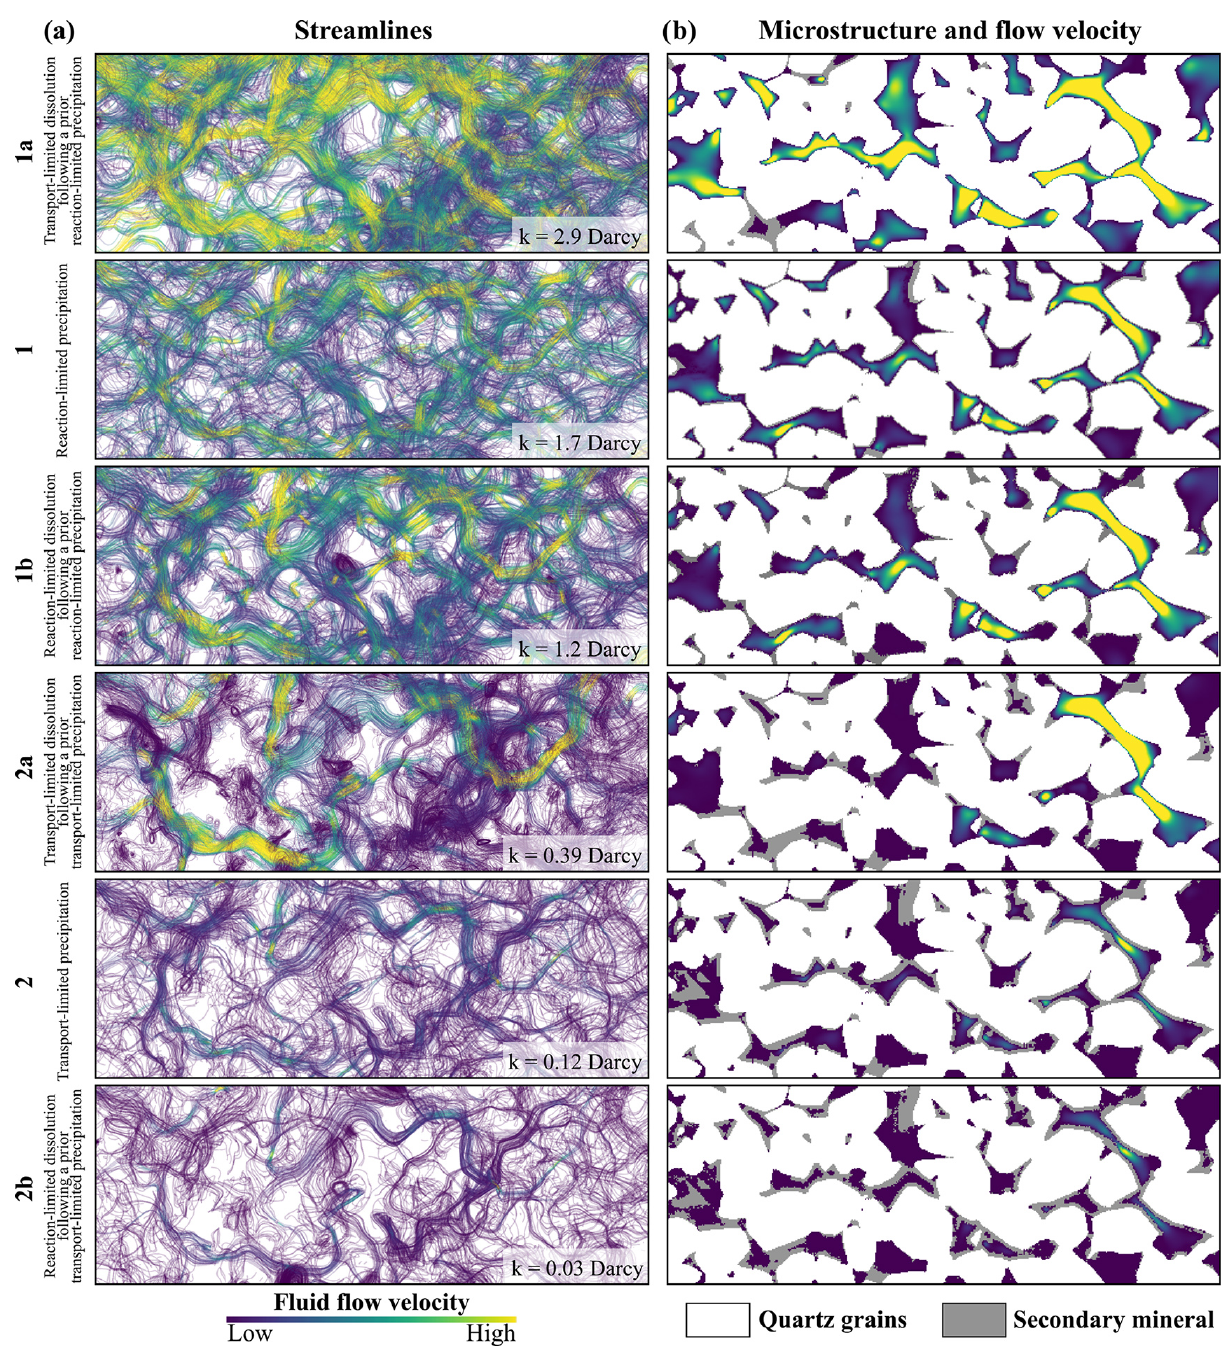
Figure 6. (a) Characteristic differences in the fluid flow regime represented by streamlines ( x – y projection of the 3D sample) at a porosity of 17.4%, where permeability varies by more than two orders in magnitude. (b) Comparison of characteristic morphometric differences and the local flow velocities within the pore space for the six simulation scenarios (1a–2b).